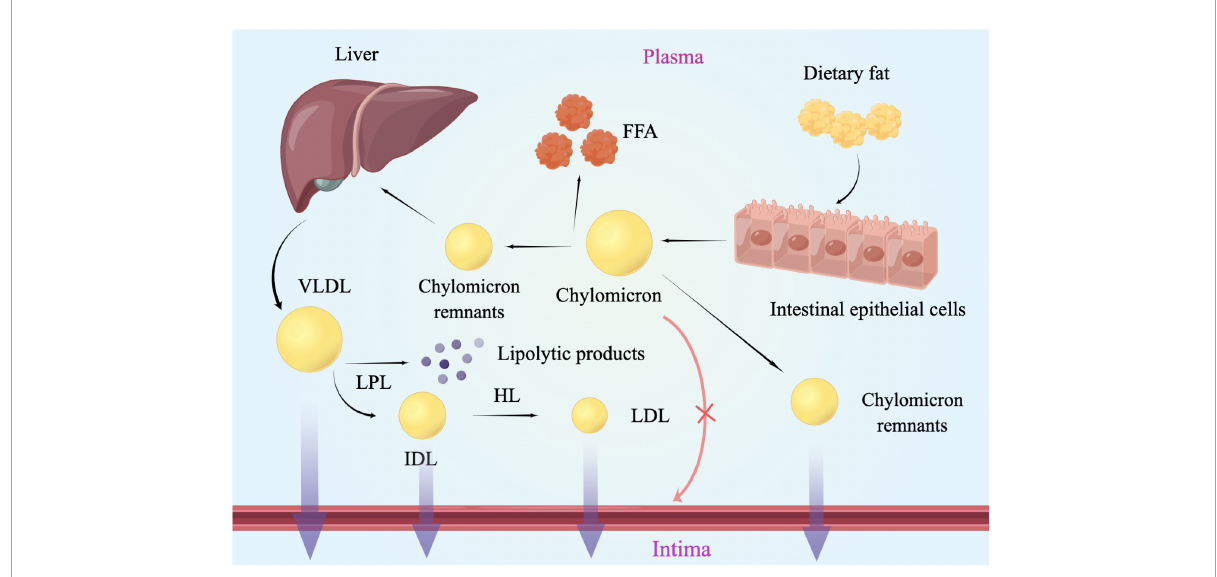
FIGURE1 Lipoproteins metabolism and the arterial wall. Chylomicrons of different sizes needed to be converted into metabolic remnants, while VLDL needed to be metabolized to LDL to be cleaned. After being digested, CM and VLDL entered into the plasma and began to be lipolysis by lipoprotein lipase. Then CM remnants and VLDL remnant-like particles with higher density and smaller molecular weight were formed, respectively. Lipoproteins larger than 75 nm were not easily available to get across the arterial intima, such as chylomicrons. LPL, lipoprotein lipase; HL, hepatic lipase; VLDL, very-low-density lipoprotein; IDL, intermediate-density lipoprotein; LDL, low-density lipoprotein; FFA, free fatty acid; RC, remnant